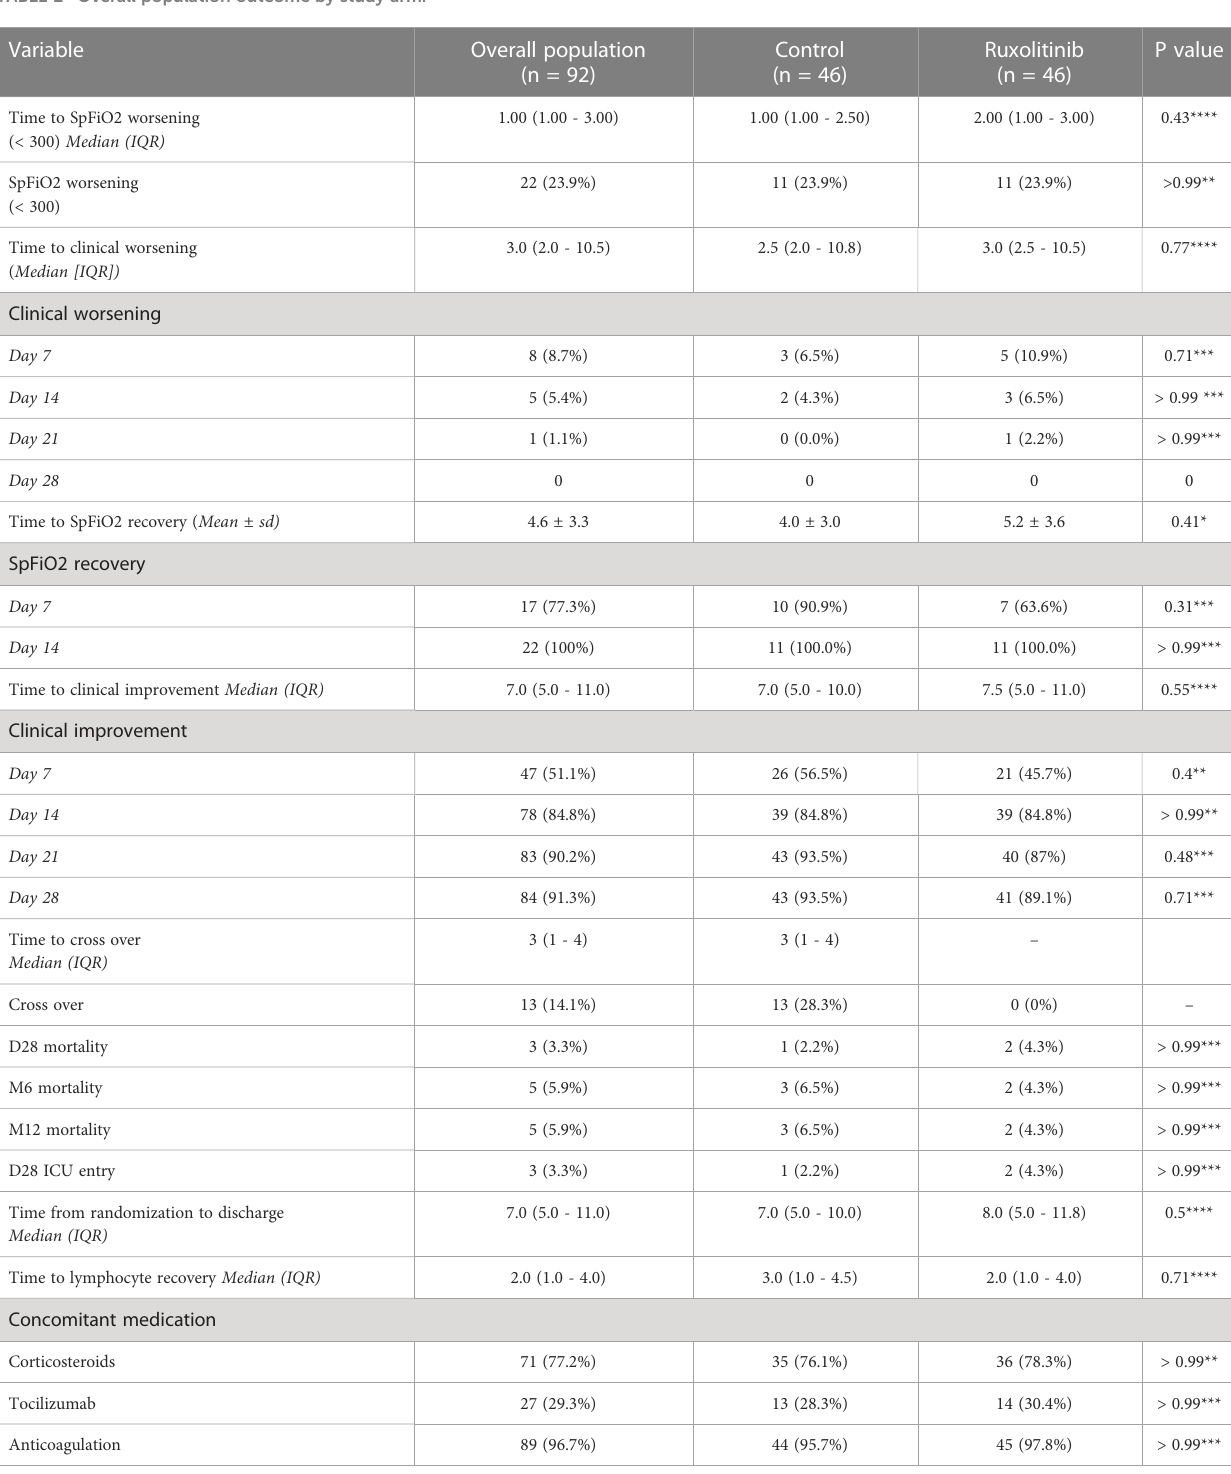
TABLE 2 Overall population outcome by study